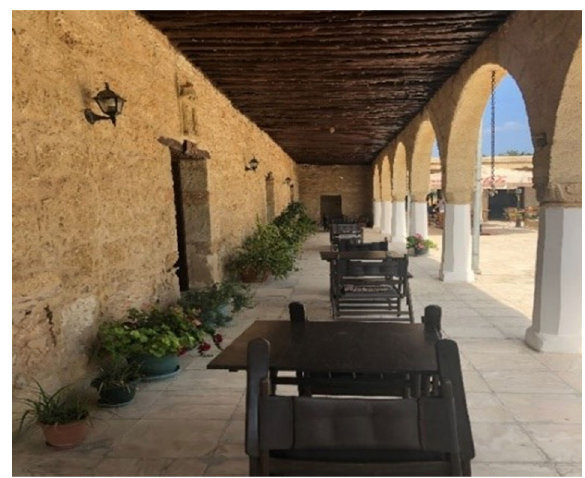
structure — Risokarpaso.